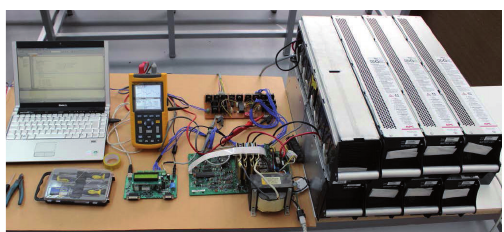
Figure 9: Datalogger, battery bank, DC-DC converters, and invert- ers in the